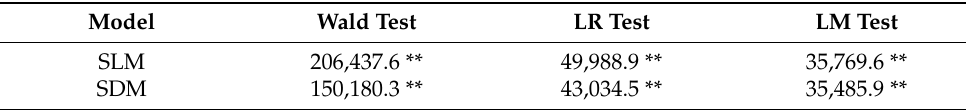
Table 3. Wald, LR and LM tests of SLM and SDM models.